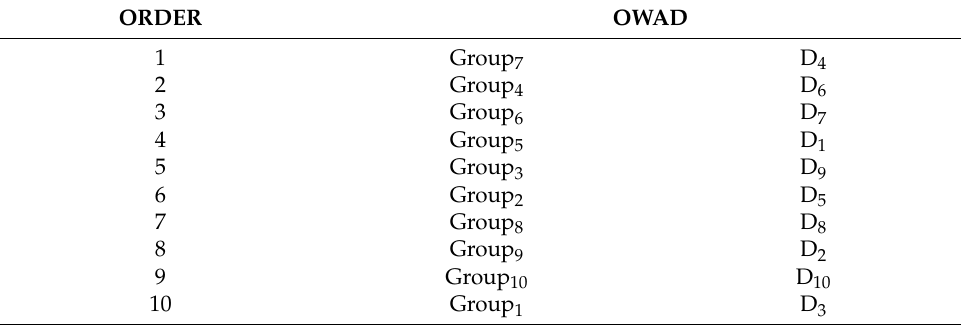
Table 14. Assignation process with OWAD